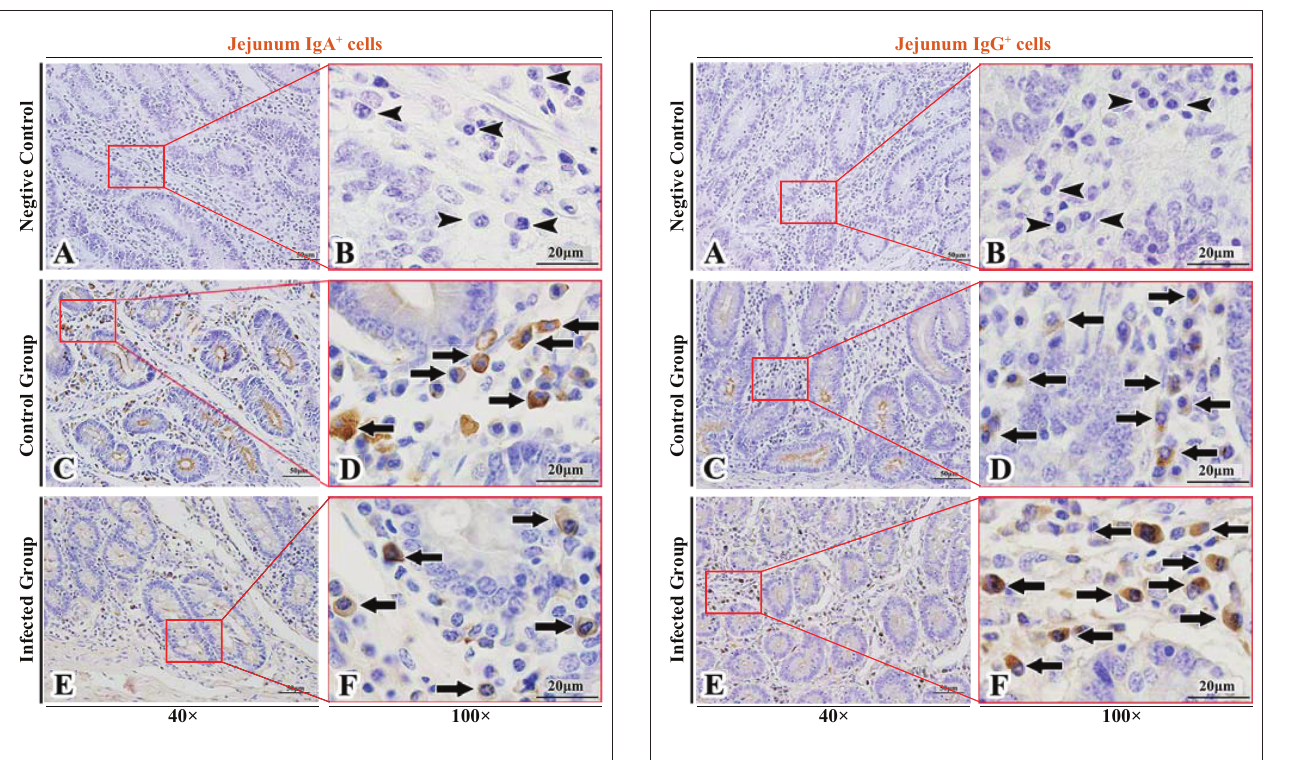
The excess fluid was shaken off, and the primary antibodies were added on the sections. After being incubated overnight at 4 ◦ C, the sections were washed with PBS (0.01 mol/L, pH 7.2) for 2 min × 3 times; the secondary antibody (HRP-linked goat anti-mouse/rabbit IgG). After being incubate at 37 ◦ C for 30 min, the sections were washed with PBS for 5 min × 4 times; SABC was added dropwise. After being incubate at 37 ◦ C for 30 min, and the sections were washed with PBS for 5 min × 4 times; colored with DAB kit (20 × , product number: